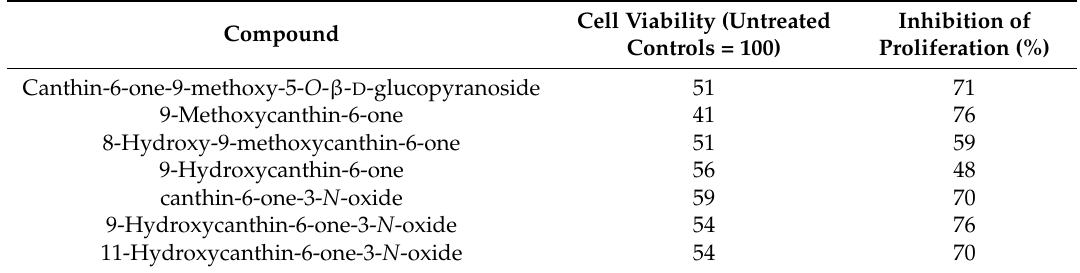
Table 2. Cell viability and inhibition of proliferation (%) in an Nf1 - and p53 -defective mouse Central Nervous System (CNS) tumor cell line by canthines at 2.0